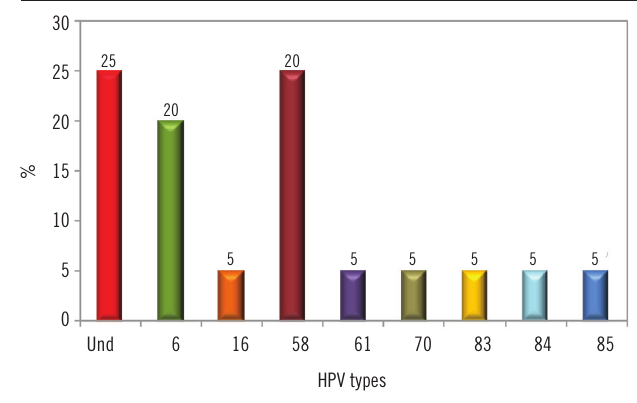
figurE − Distribution of HPV types found in HPV-positive samples HPV: human papillomavirus; Und: undetermined.